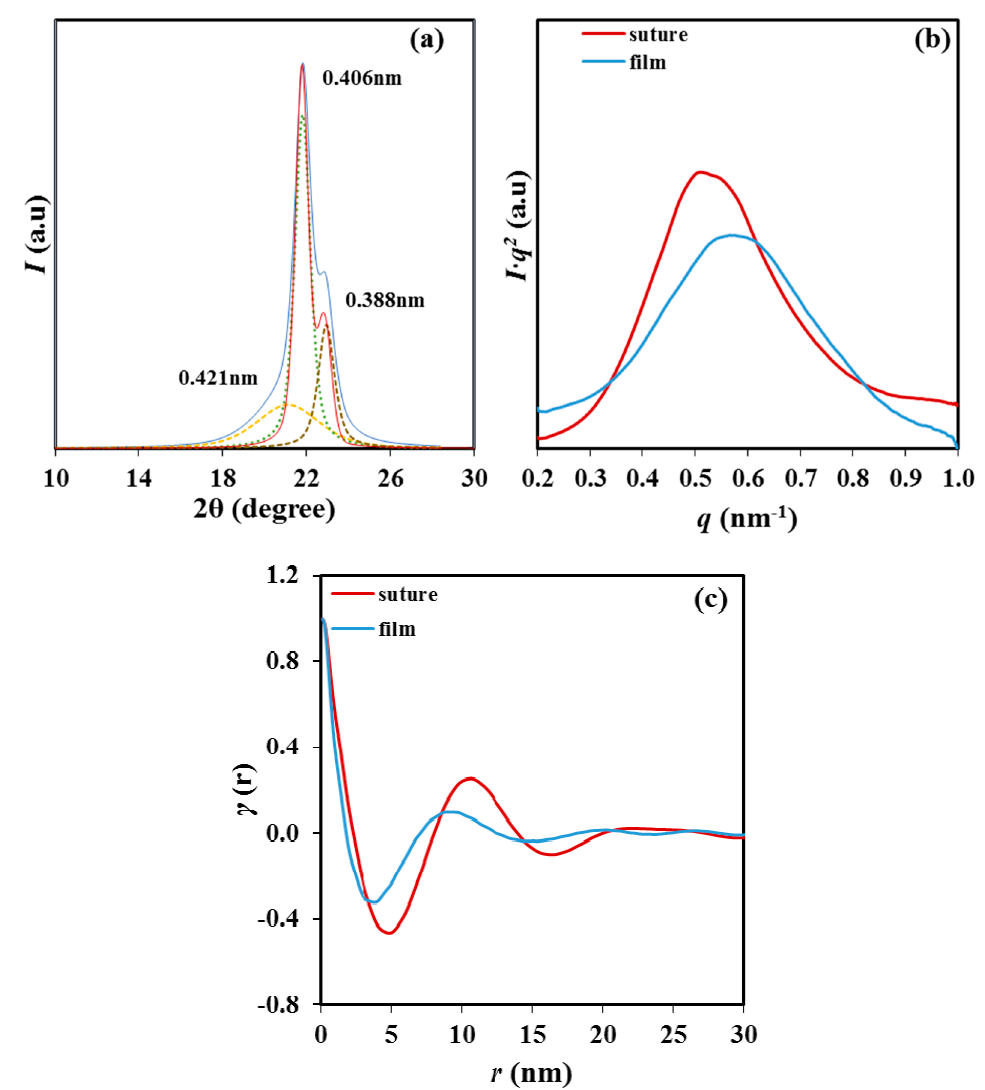
Figure 3. Wide angle X-ray di ff raction (WAXD) profiles ( a ); Small angle X-ray scattering (SAXS) profiles ( b ) and correlation functions ( c ) of the initial commercial P4HB suture (red line) and a P4HB melt crystallized sample (blue line). Deconvoluted WAXD peaks are only indicated for the melt crystallized